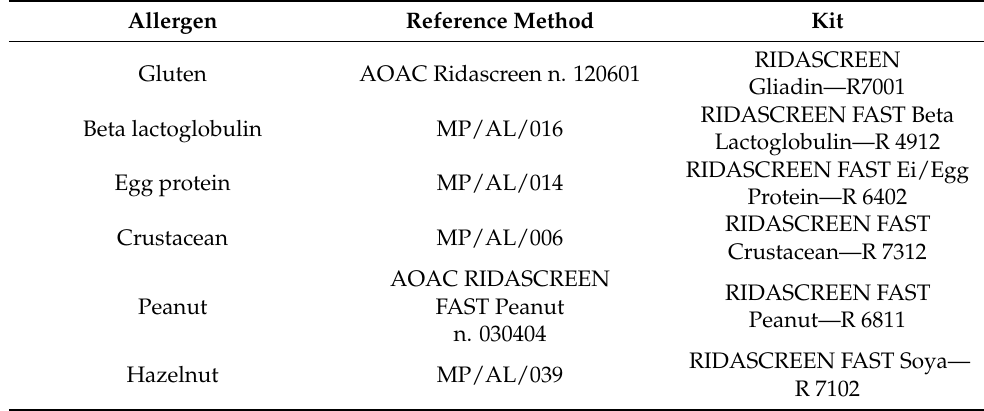
Table 3. Allergens and detection methods plus reference